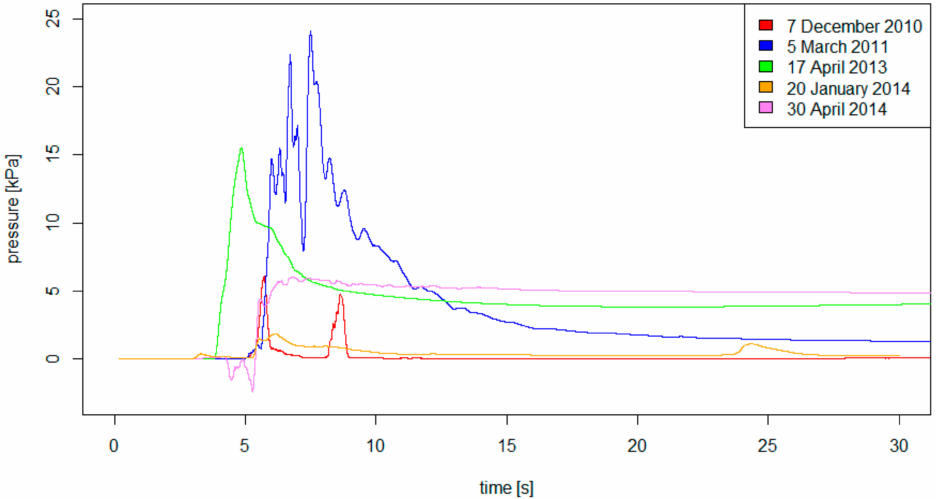
Figure 14. Total impact pressures for the five selected avalanches (values averaged over 0.2 s). The beginning of the measurements does not represent the arrival time of the avalanches at the obstacle, as the triggering of the measuring system might have been different for the five events. Figure S44–S48 in the Supplementary Materials report the total force for each avalanche as raw data and averaged over 0.2